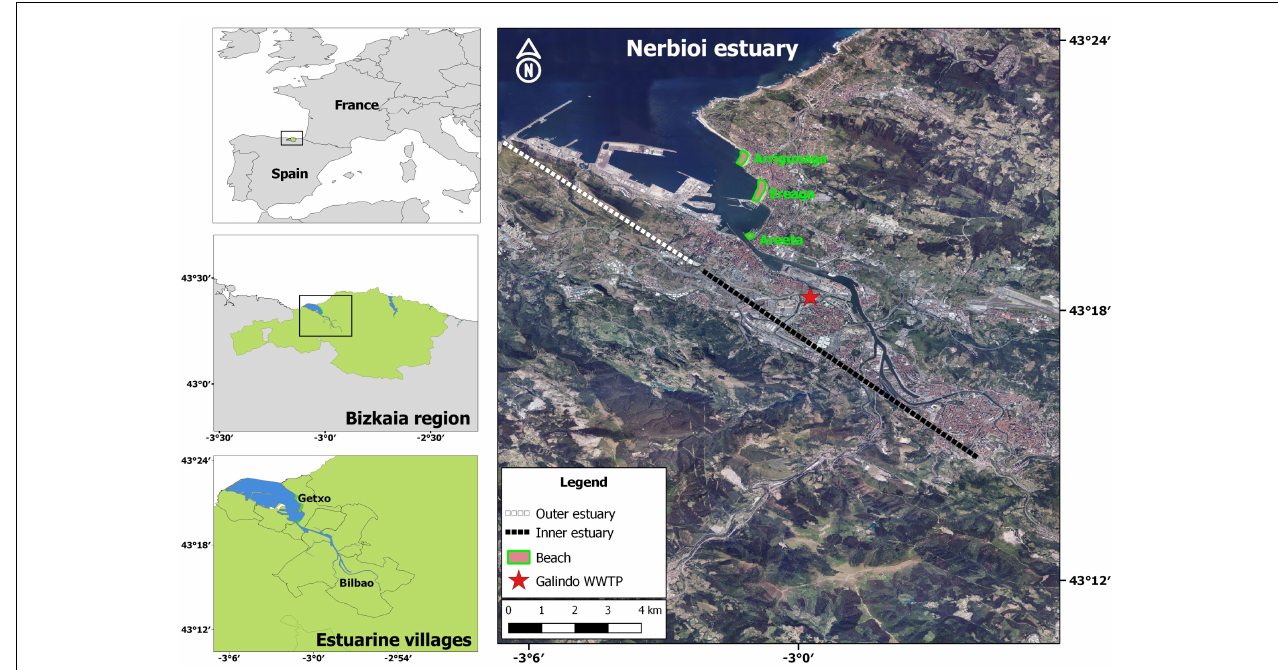
FIGURE 1 | Location of the Nerbioi estuary at different geographical scales (within the Bay of Biscay and Bizkaia region); and location of the three beaches in the outer part of the Nerbioi estuary. WWTP, Wastewater Treatment Plant.